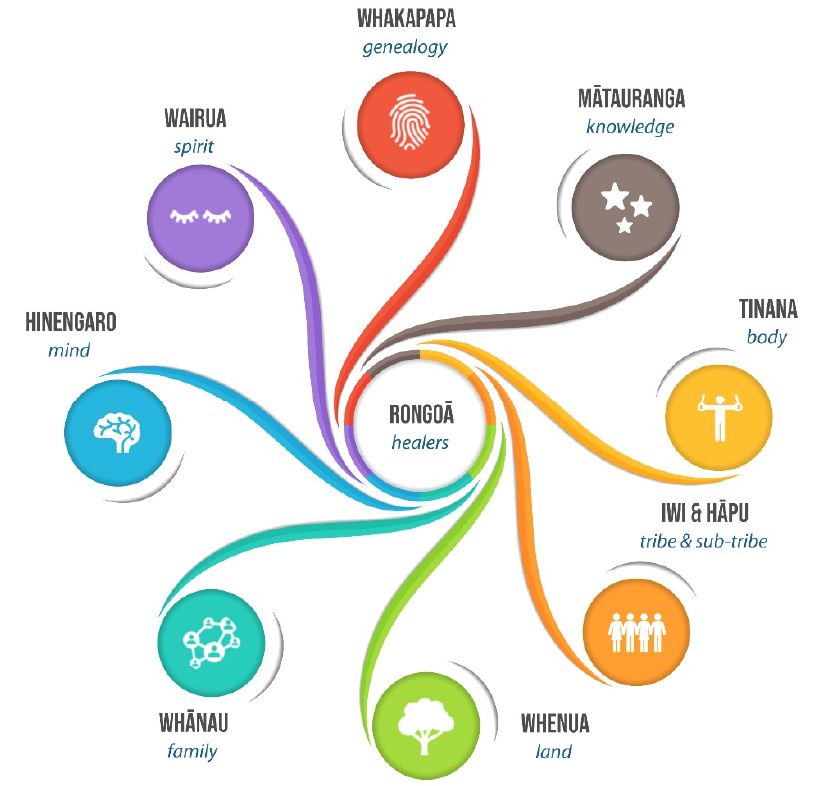
Figure 1. The essential elements that are part of the practice of rongoā.